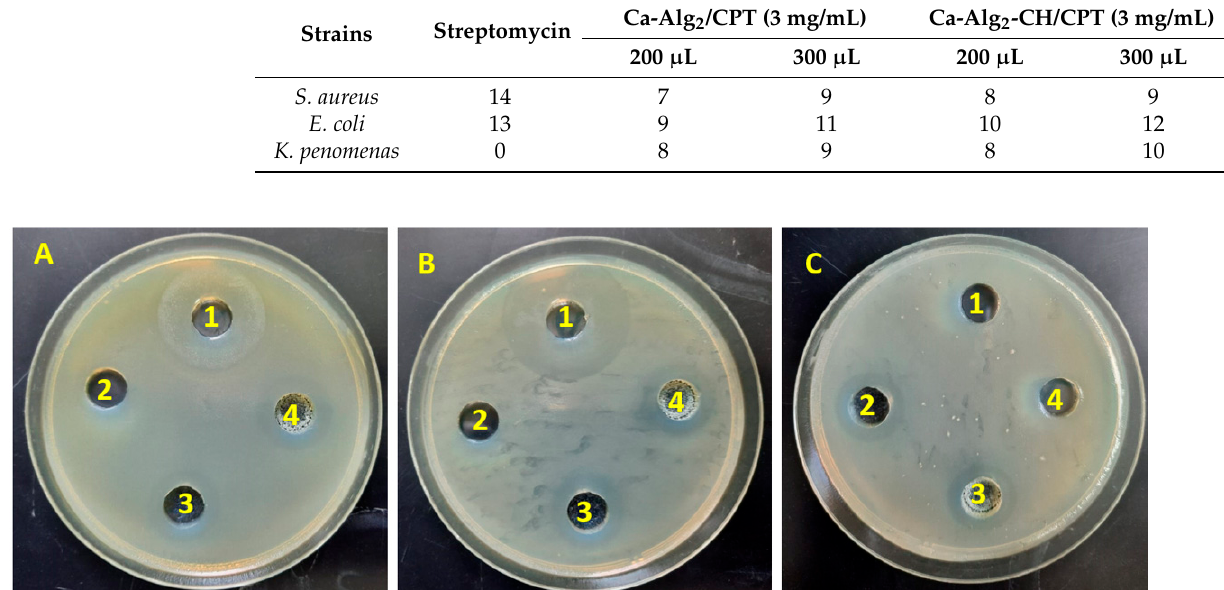
Table 1. Diameter of inhibition zone (DIZ) in mm of three bacterial strains caused by Ca-Alg 2 /CPT and Ca-Alg 2 -CH/CPT nanomaterials.